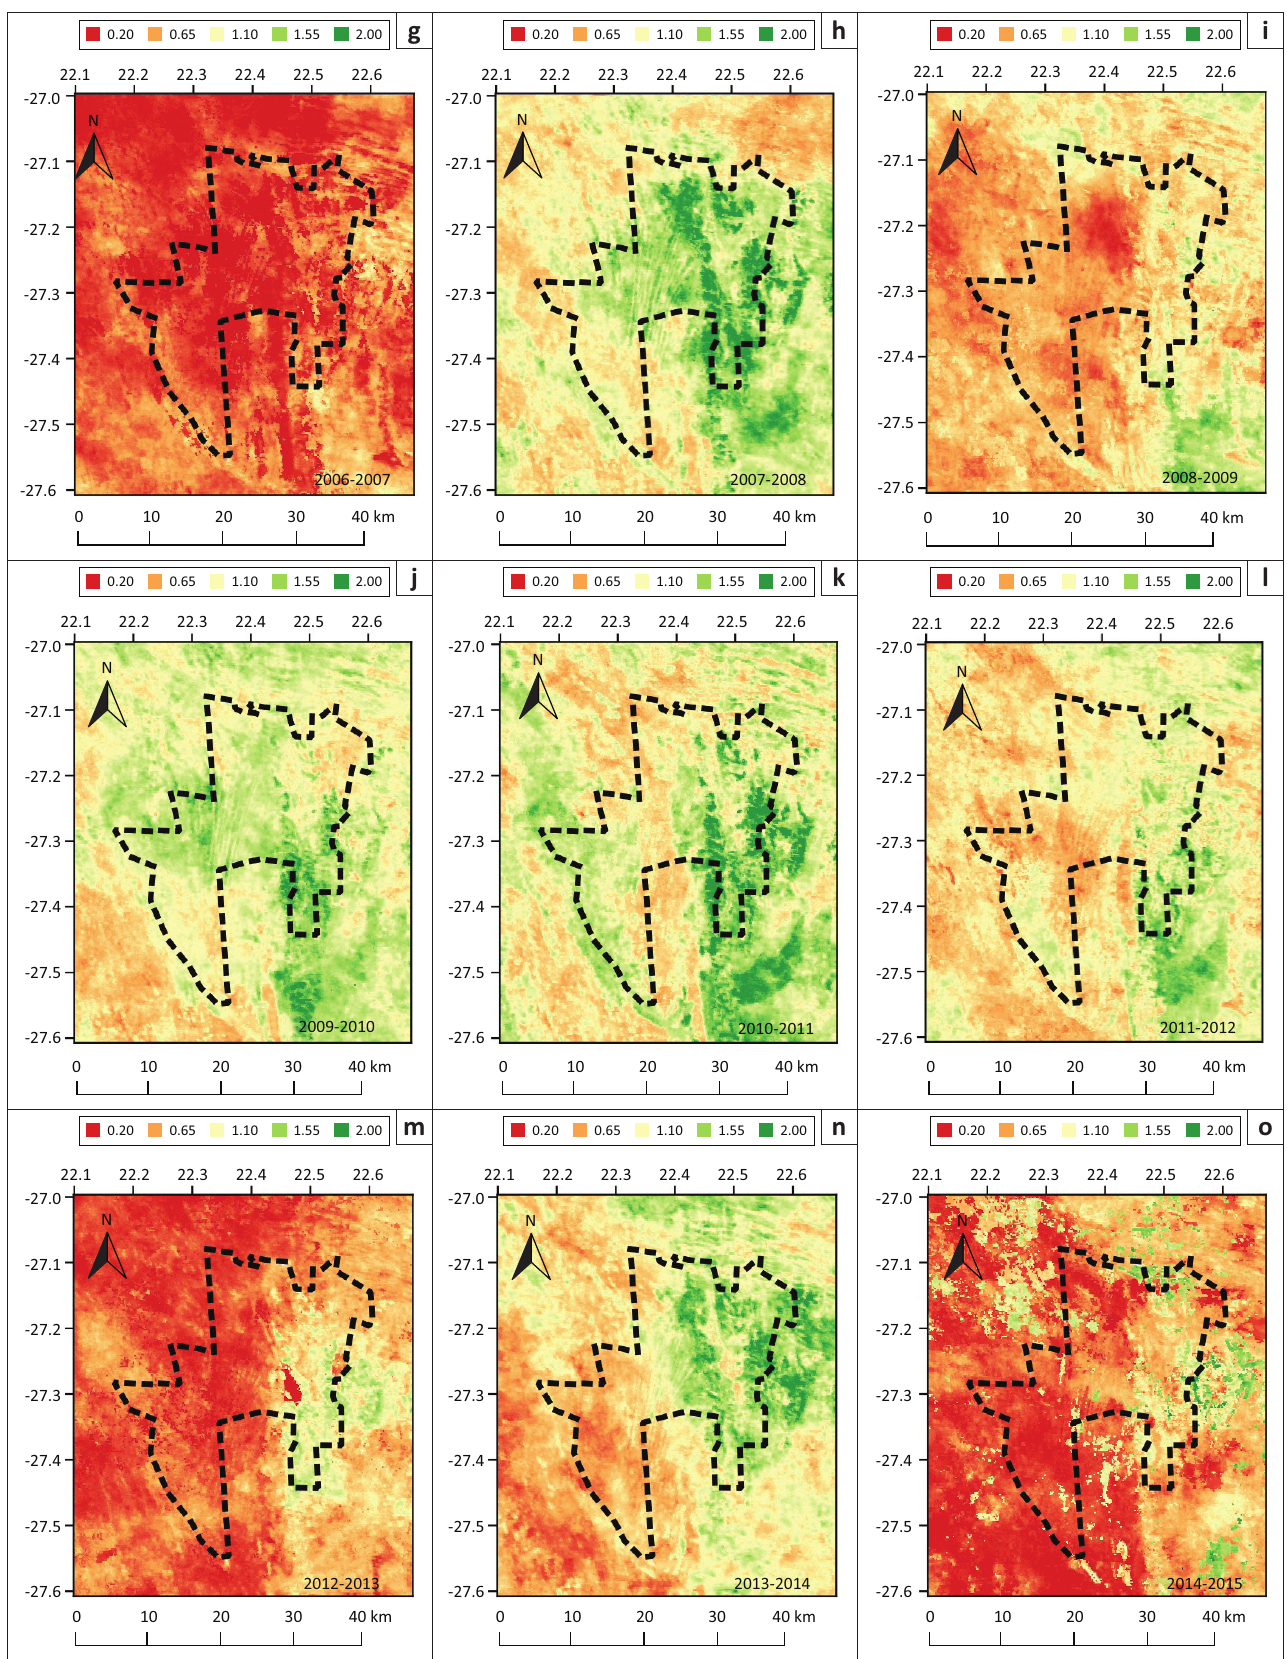
FIGURE 2 (Continues...): A composite image of the annual small integrated value of the Enhanced Vegetation Index in the Tswalu Kalahari Reserve for the 2000–2001 to 2014–2015 growth season, which starts at the beginning of October and ends at the end of September. Red colours indicate a lower Enhanced Vegetation Index value corresponding to lower plant productivity. (a) 2000–2001, (b) 2001–2002, (c) 2002–2003, (d) 2003–2004, (e) 2004–2005, (f) 2005–2006, (g) 2006–2007, (h) 2007–2008, (i) 2008–2009, (j) 2009–2010, (k) 2010–2011, (l) 2011–2012, (m) 2012–2013, (n) 2013–2014 and (o)